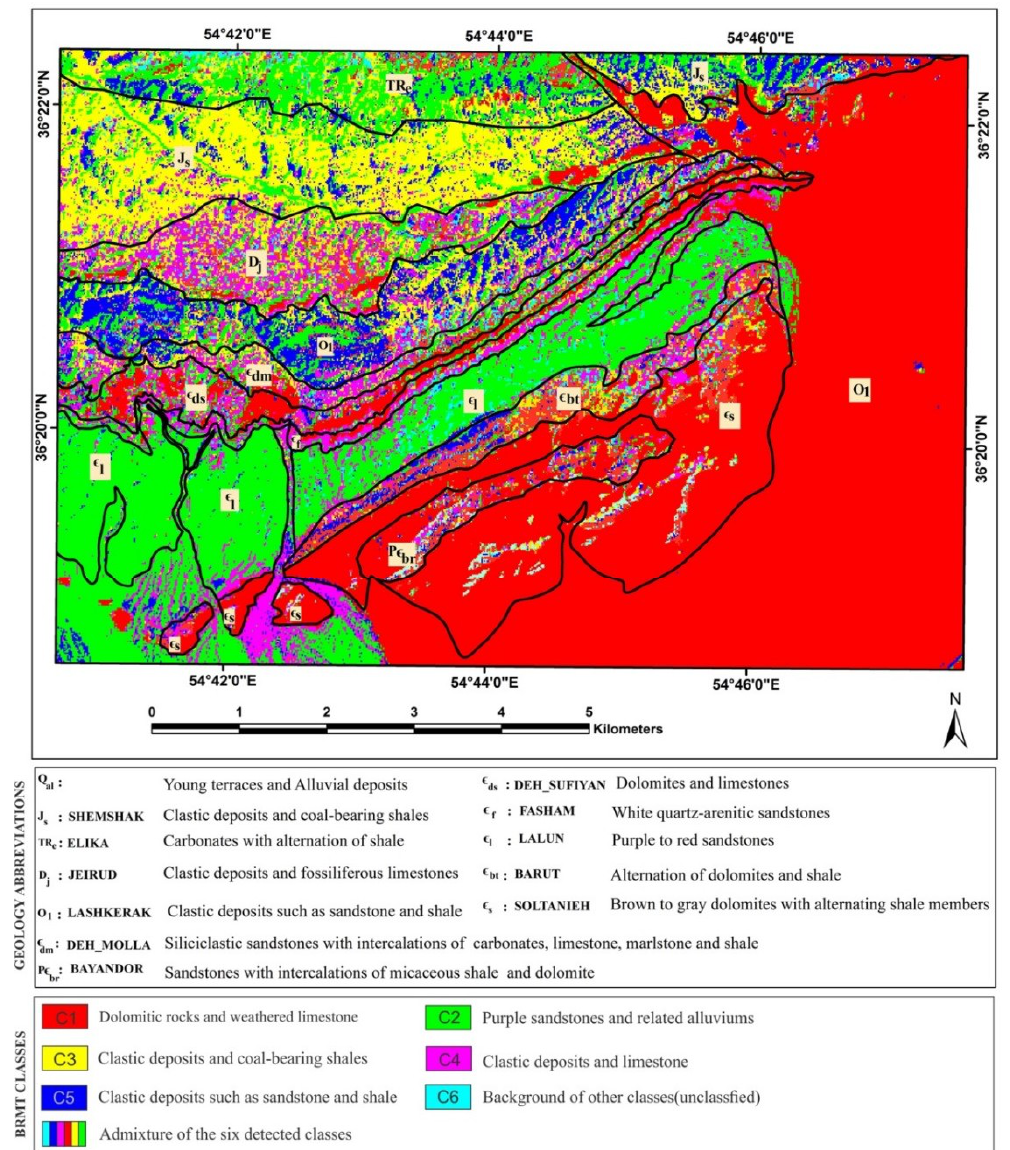
Figure 6. BRMT classification map of the Deh-Molla region.